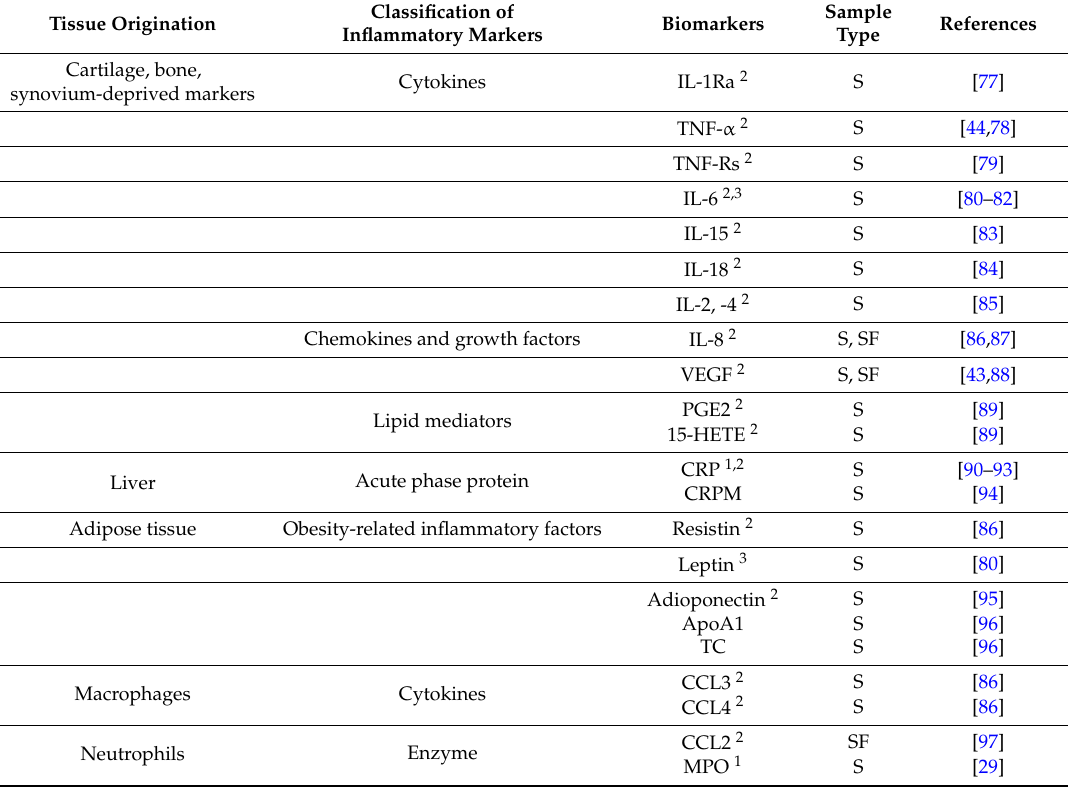
Table 2. Classification of inflammatory markers in OA and studies of these markers in patients. Tissue